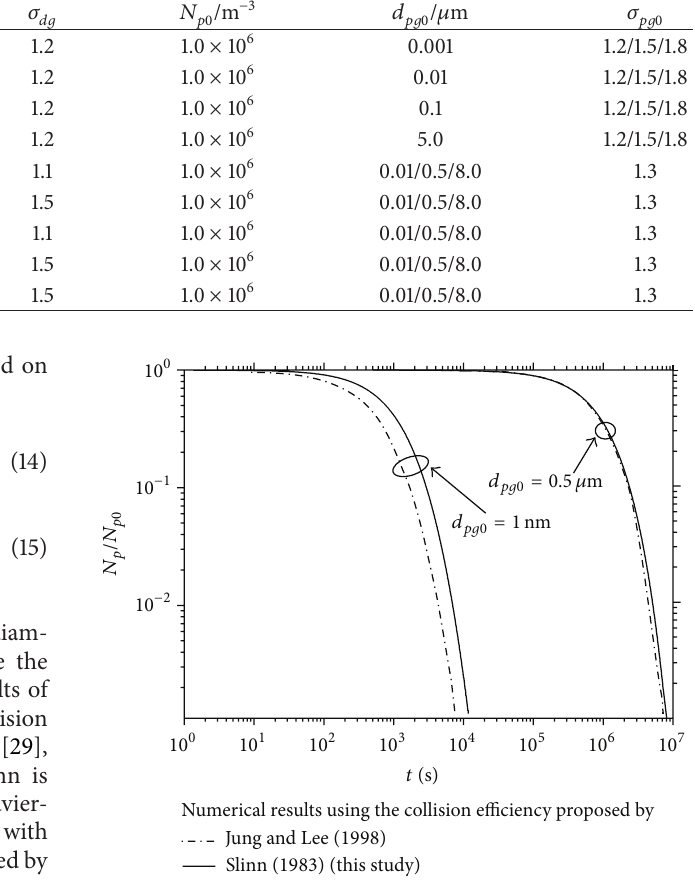
Figure 1: Comparison of particle number concentrations based on different collision